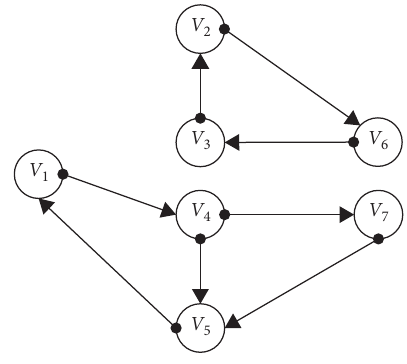
Figure 1: A graph with 7